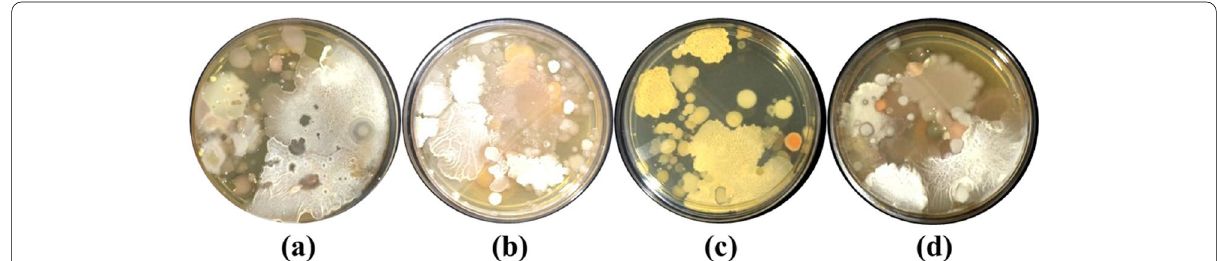
Fig. 4 Microbial growth in the sample for microbial colonies isolated from soil a pure TMAOH (25% in water), b recycled TMAOH, and microbial colonies isolated from industrial sludge c pure TMAOH (25% in water), and d recovered